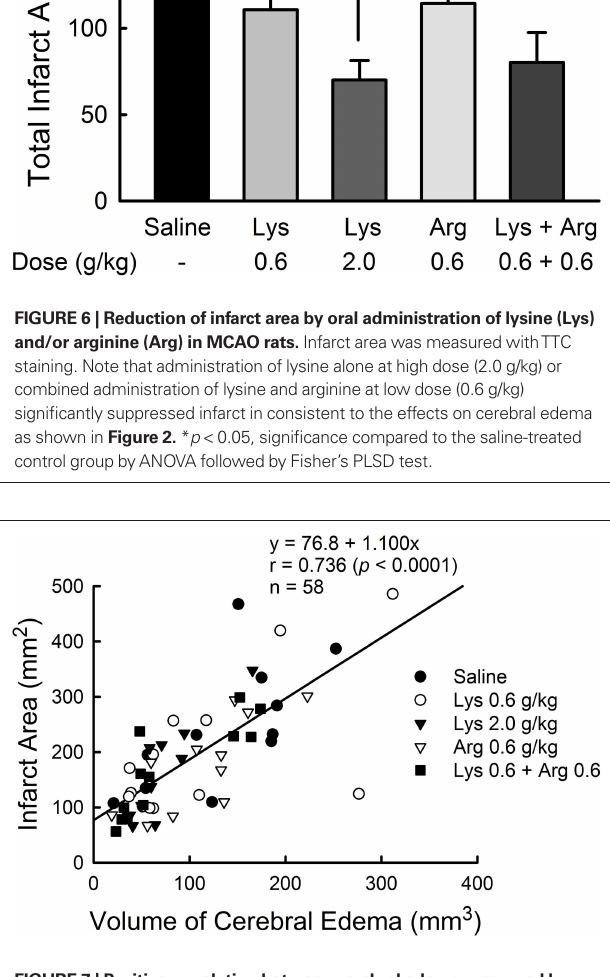
FIgure 7 | Positive correlation between cerebral edema measured by MrI and infarct area measured by TTC staining in MCAO rats. Data from all experimental groups were combined for analysis. Y = 76.8 + 1.100 X , r = 0.736, p < 0.0001.